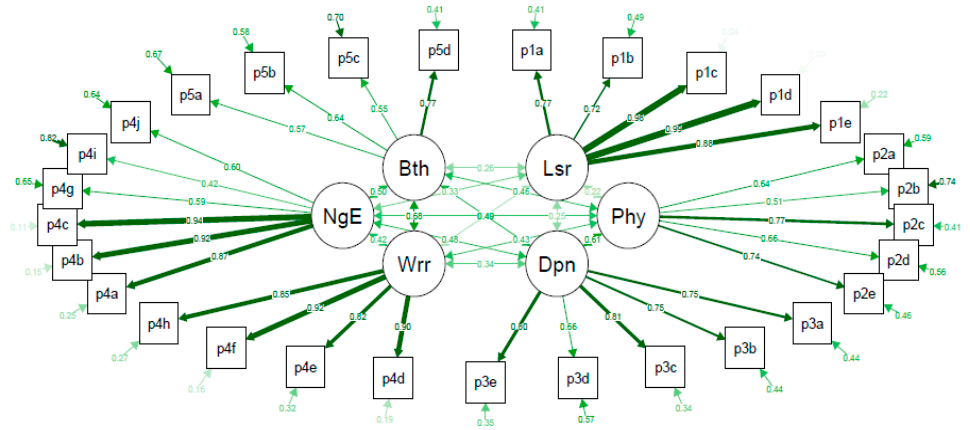
Figure 1. Confirmatory factor analysis of the different subscales of the Diabetes Foot Ulcer Scale-Short Form (DFS-SF). Bth, bothered by ulcer care; NgE, negative emotions; Wrr, worried about ulcers/feet; Lsr, leisure; Phy, physical health; Dpn, dependence/daily life. p1a–p5d are the items per subscale of